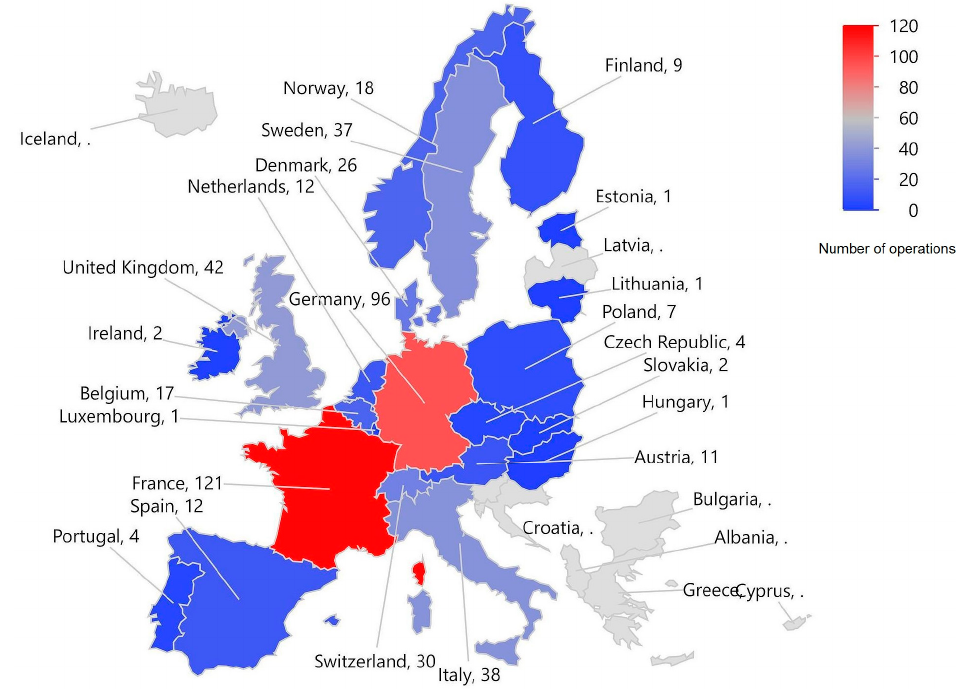
Figure 1. Waste-to-energy operations in the EU in 2018.